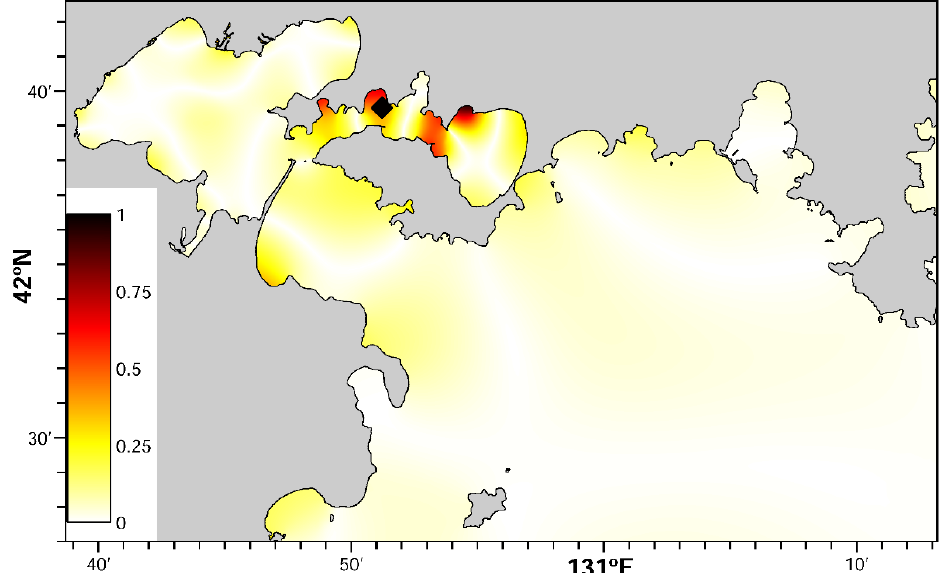
Figure 4. Distribution of oscillation amplitude with period of 18.165 min during the meridional wind. Diamond—point of oscillation measurements.